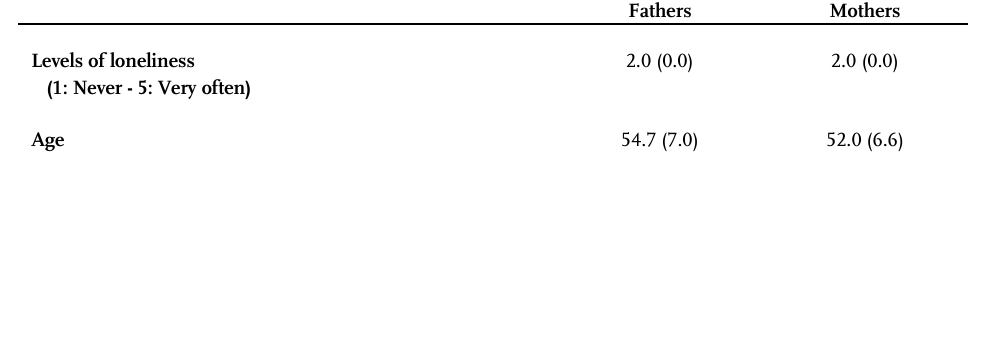
Fathers Mothers